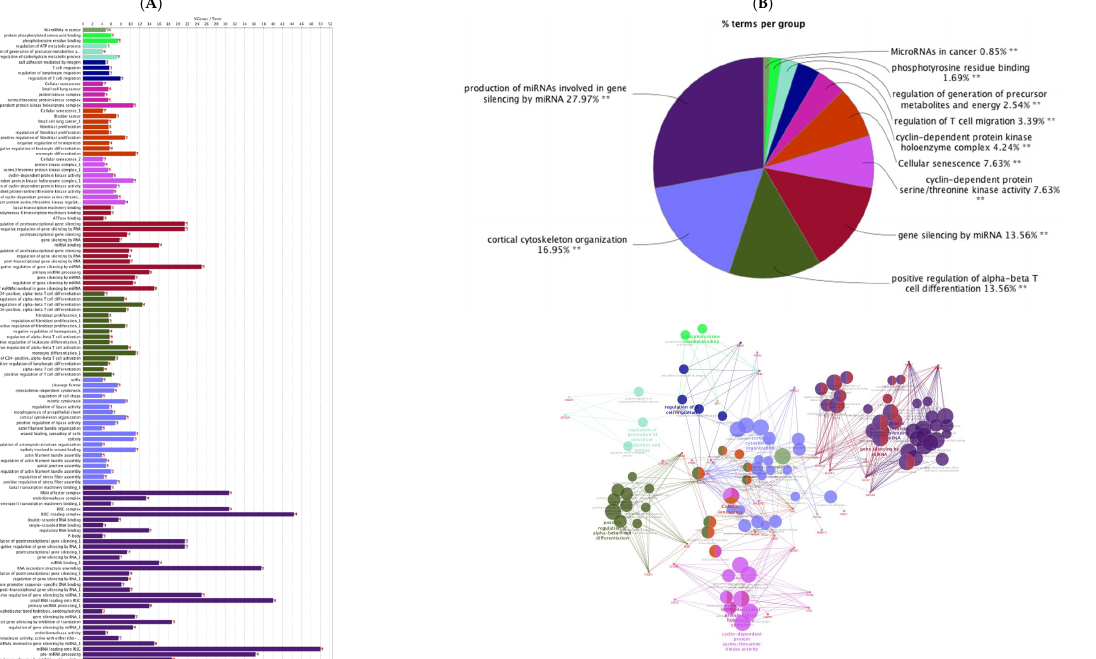
Figure 4. ClueGO analysis of up-regulated genes in sperm and seminal plasma from high-fertile bulls. ( A ) GO/pathway terms specific for upregulated genes. The bars represent the number of genes associated with the terms. The percentage of genes per term is shown as bar label; ( B ) overview chart with functional groups including specific terms for upregulated genes; ( C ) functionally grouped network with terms as nodes linked based on their kappa score level (≥0.4), where only the label of the most significant term per group is shown. The node size represents the term enrichment significance. Functionally related groups partially overlap. The color gradient shows the gene proportion of each cluster associated with the term. Single (*) or double (**) asterisk indicate significant enriched GO terms at the p < 0.05 and p < 0.01 statistical